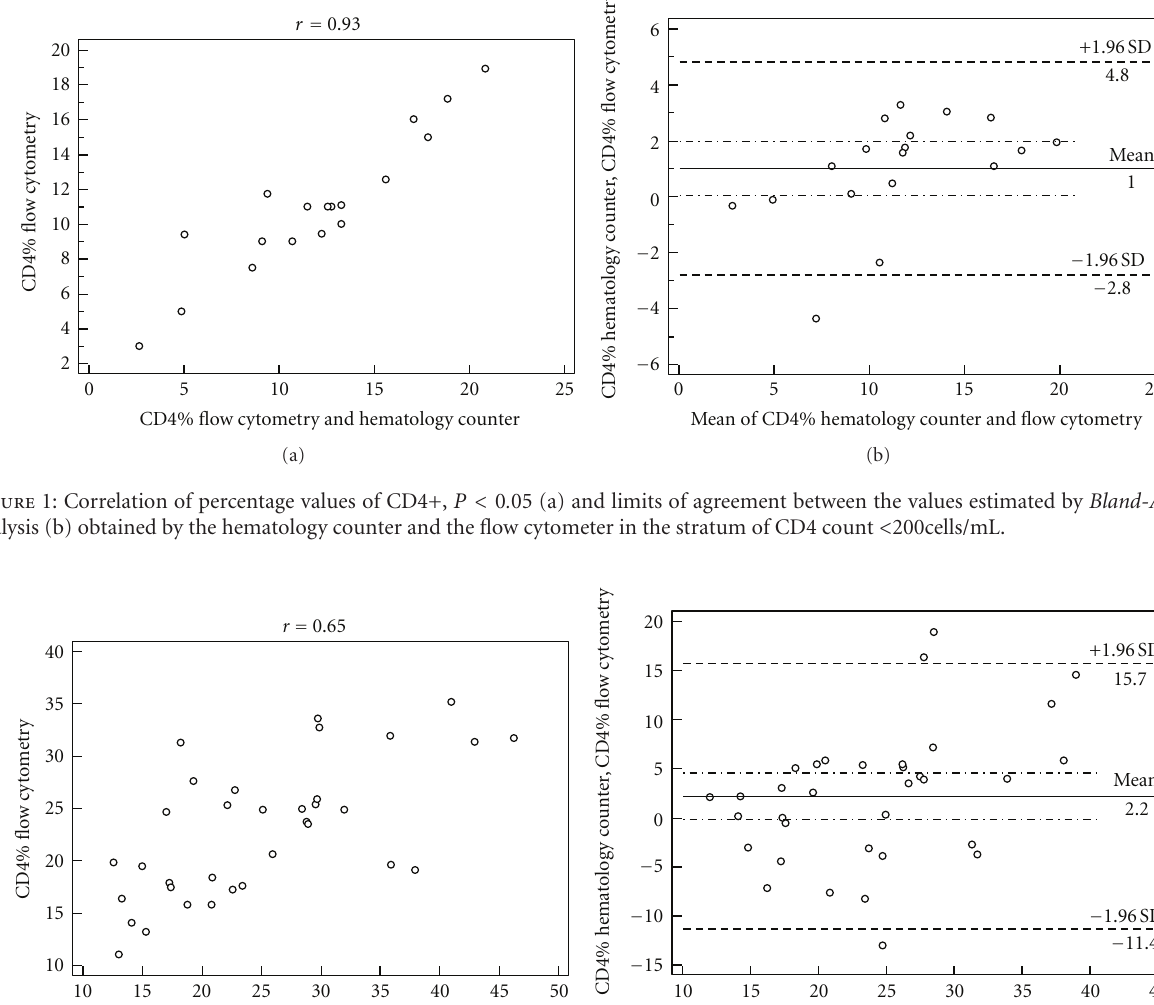
Figure 2: Correlation of percentage values of CD4+, P < 0 . 05 (a) and limits of agreement between the values estimated by Bland-Altman analysis (b) obtained by the hematology counter and the flow cytometer in the stratum of CD4 count between 200 and 500